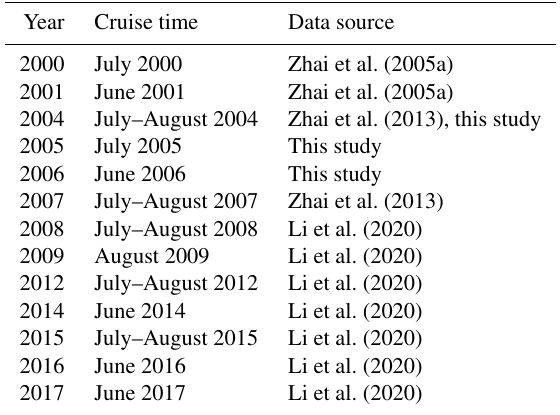
Table 1. Underway sea surface p CO 2 data in summer in the SCS compiled in this